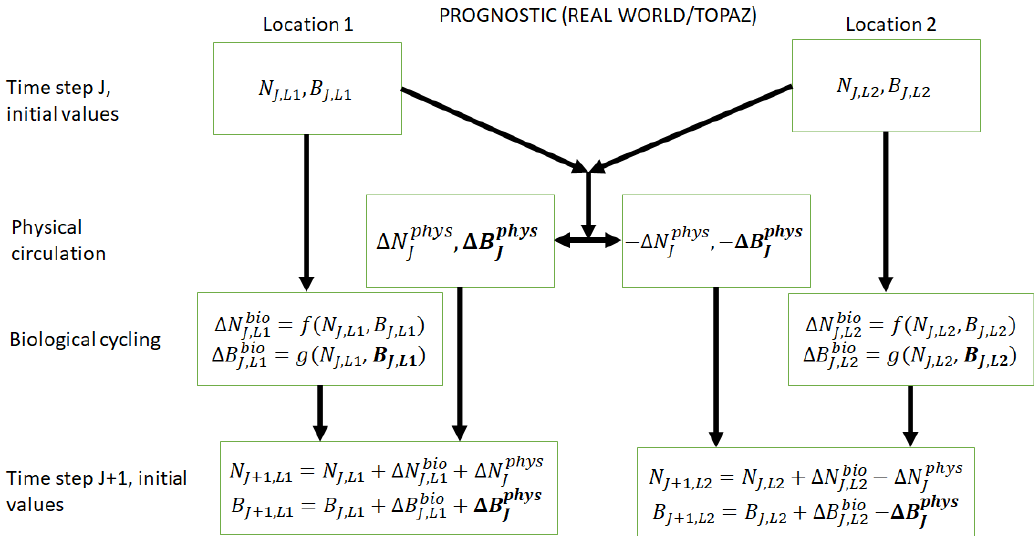
Figure 2. Conceptual diagram of how biogeochemical evolution is computed within an ESM using the prognostic TOPAZ BC. The letters and abbreviations represent nutrients ( N ), phytoplankton biomass ( B ), the physical circulation component (phys), and the biological cycling component (bio). This ESM differs from the one described in Fig. 1. In this prognostic model, the changes in biomass from the biological cycling component are a function of the nutrients and biomass rather than nutrients alone. Additionally, a change in biomass due to physical circulation is